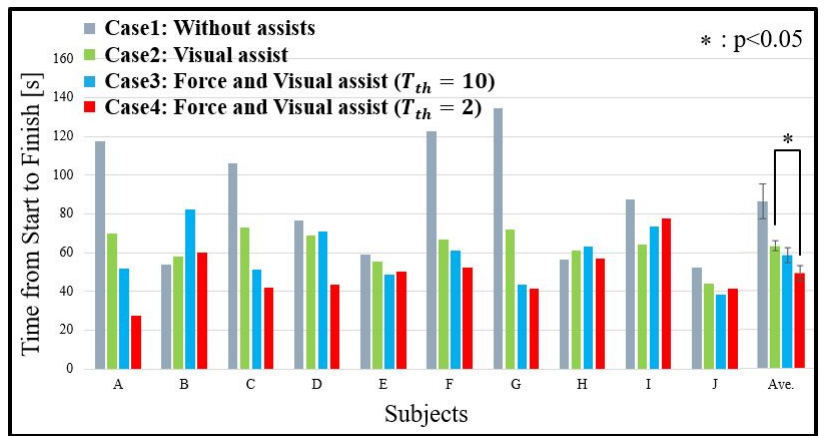
Figure 12. Experimental results of time from start to finish.